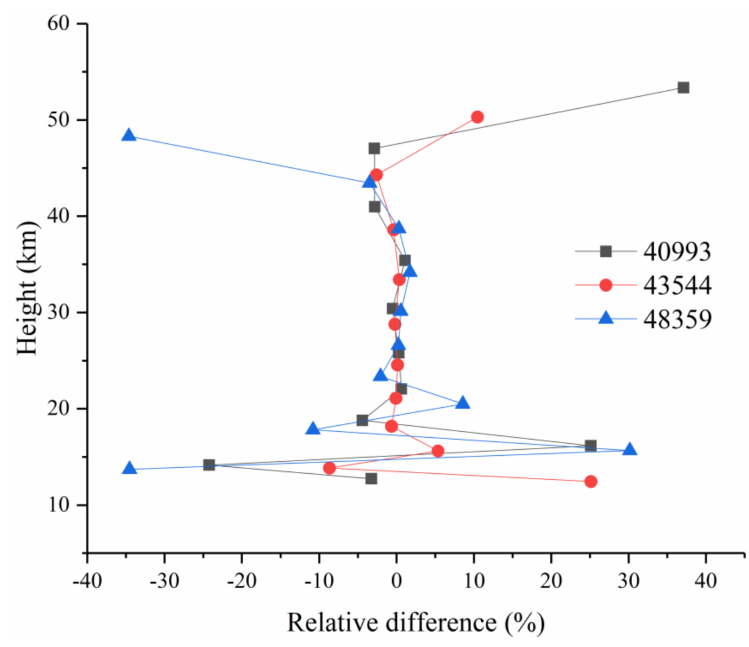
Figure 13. NO 2 relative differences for orbits sr40993, sr43544, and sr48359.